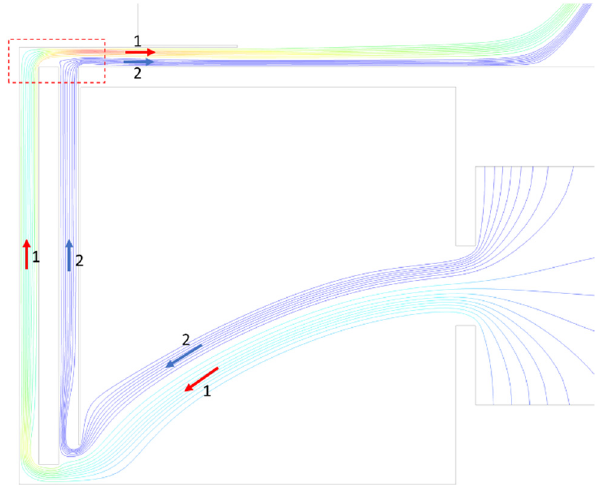
Figure 8. Streamlines of Configuration (III) in Figure 6 for q 2 = 100 W/m 2 .